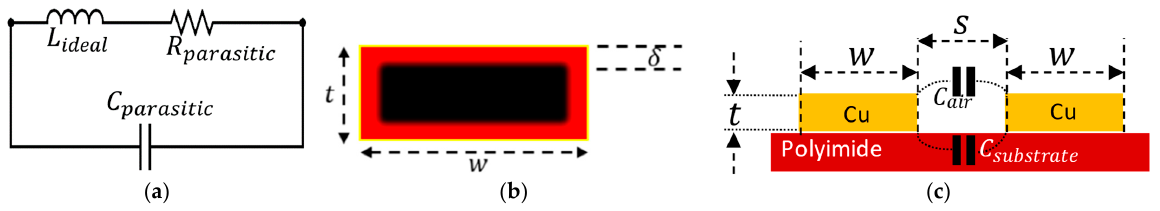
Figure 4. Lumped model of the elliptical planar inductor to show parasitic effects ( a ) Lumped circuit model of the planar inductor ( b ) Skin depth ( δ ) shown in the red area where current flows through the red area instead of the complete cross-sectional area of conductor ( c ) Parasitic capacitance between nearby